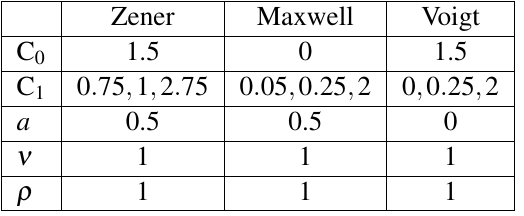
model to linear